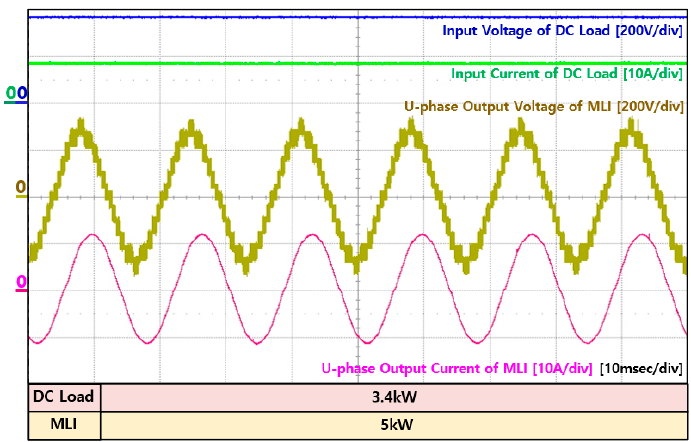
Figure 11. Experiment waveforms of interfacing converter and WT converter in mode 1.